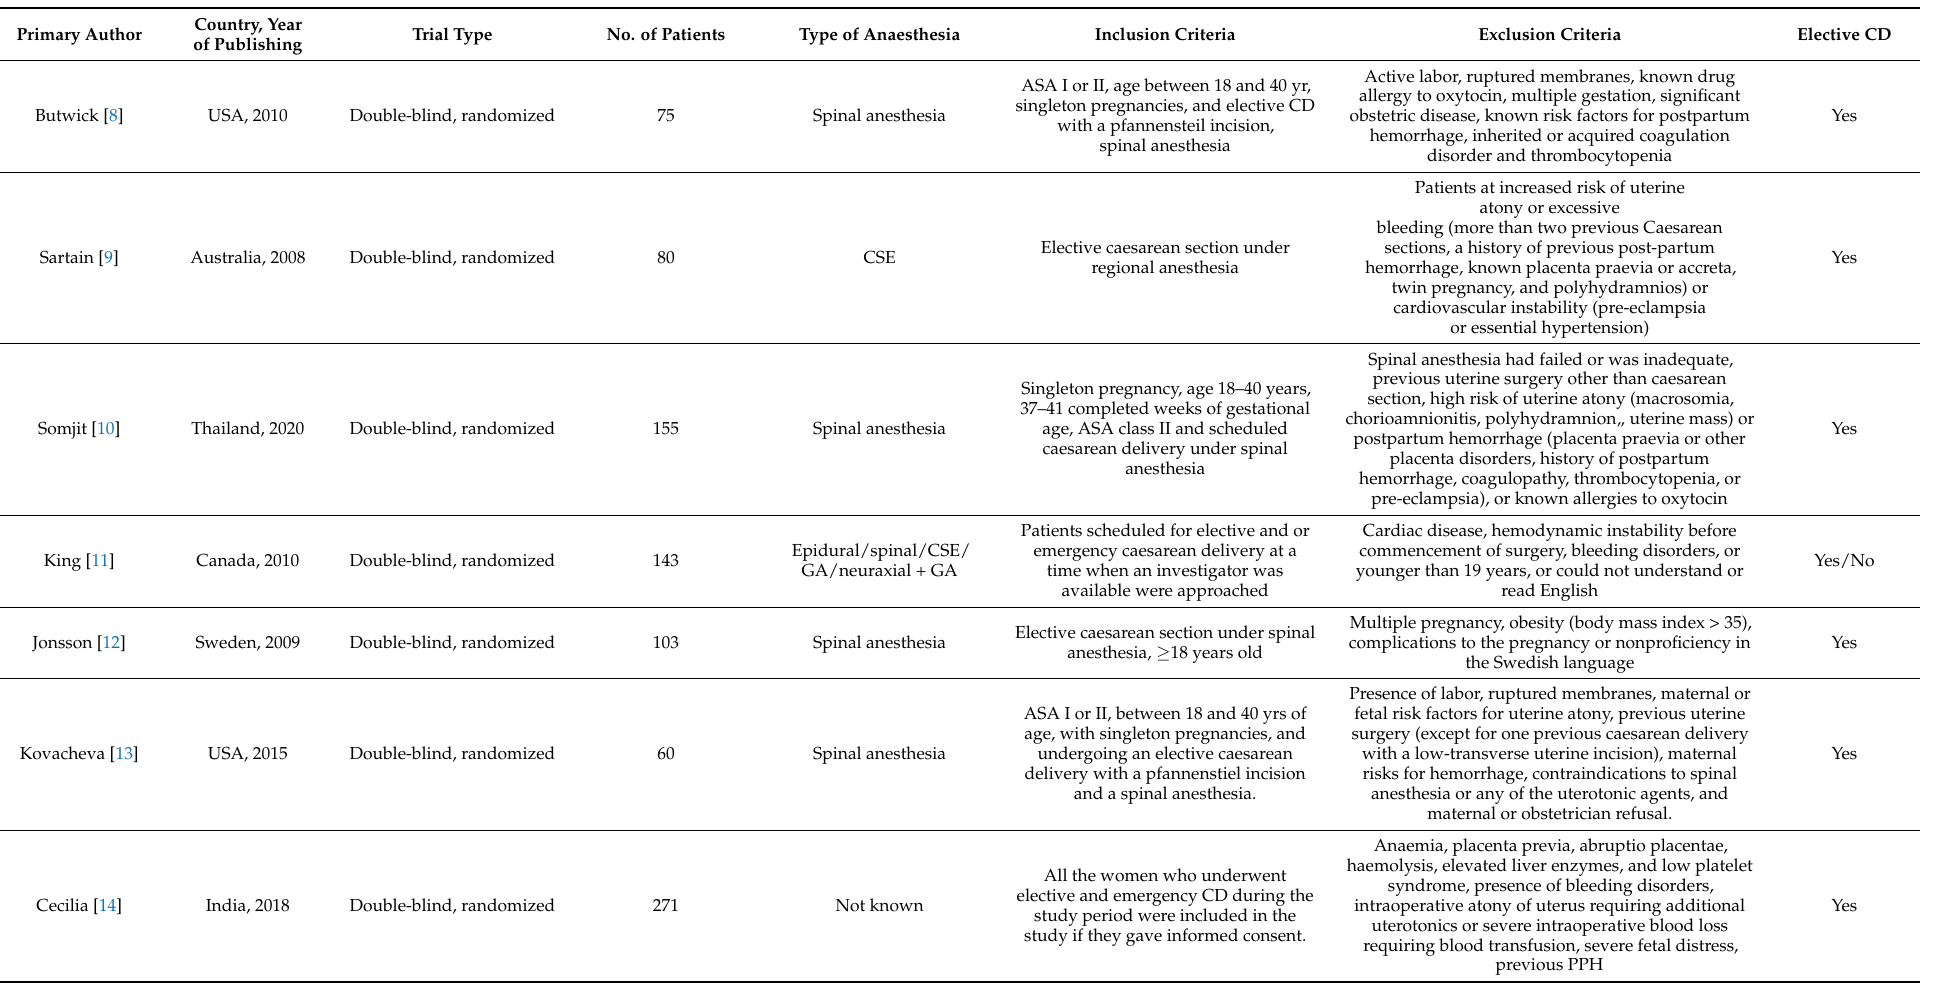
Table 1. Descriptive characteristics of the different trials which researched oxytocin’s bolus, infusion or